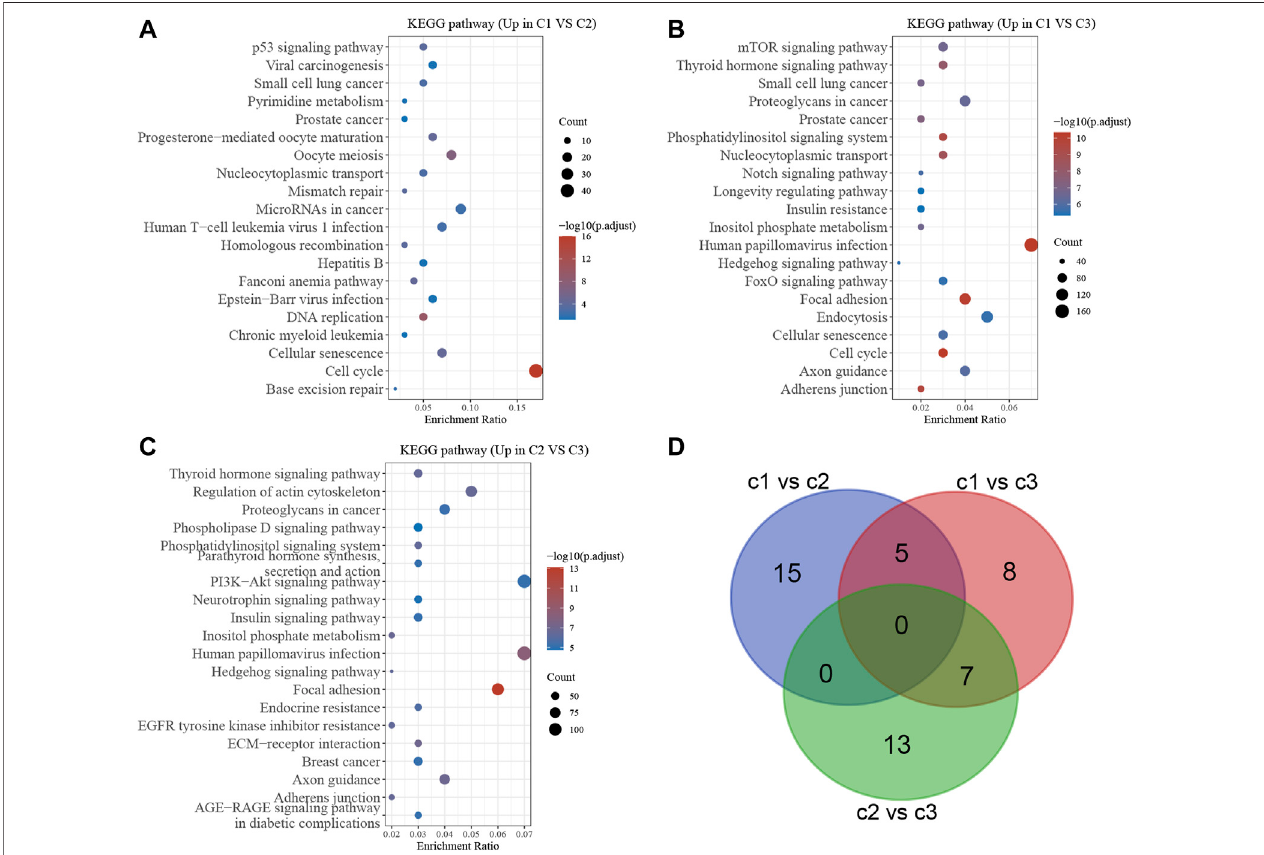
FIGURE6 | Bioinformatics analysisof DEGs in different stress granule subtypes ofNSCLC. (A) Bioinformatics analysisof DEGs between subtype 1 and subtype 2 in NSCLC. (B) Bioinformatics analysis of DEGs between subtype 1 and subtype 3 of NSCLC. (C) Bioinformatics analysis of DEGs between subtype 2 and subtype 3 of NSCLC. (D) Venn map analysis showed stress granule related signaling of